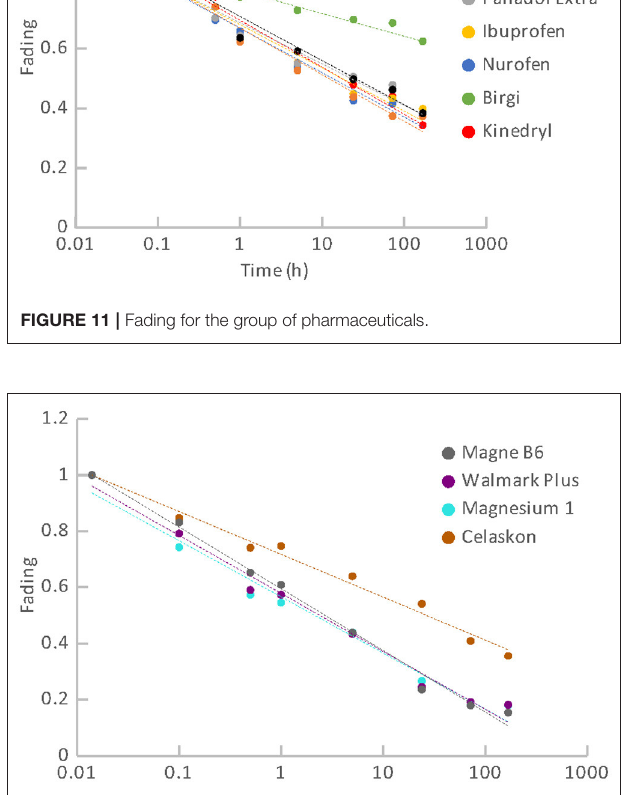
Fading for vitamin C (Celaskon) is rather similar to fading of the